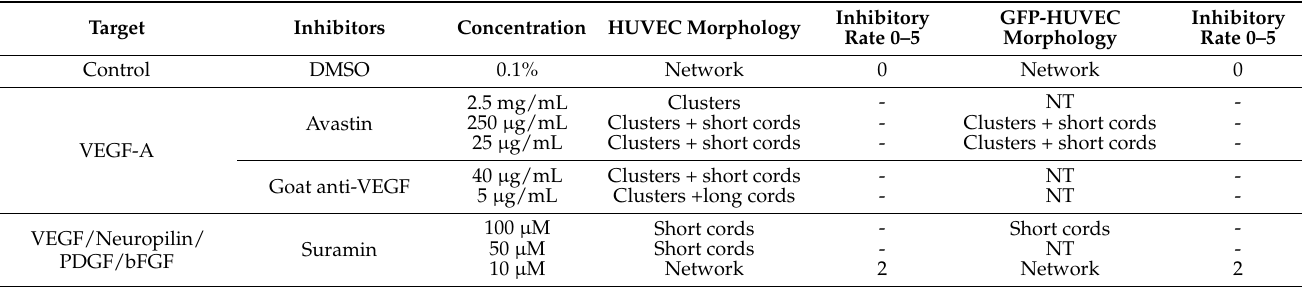
Table 1. Effect of inhibitors on HUVECs and GFP-HUVECs. Inhibitory rate is only given in relation to degree of network